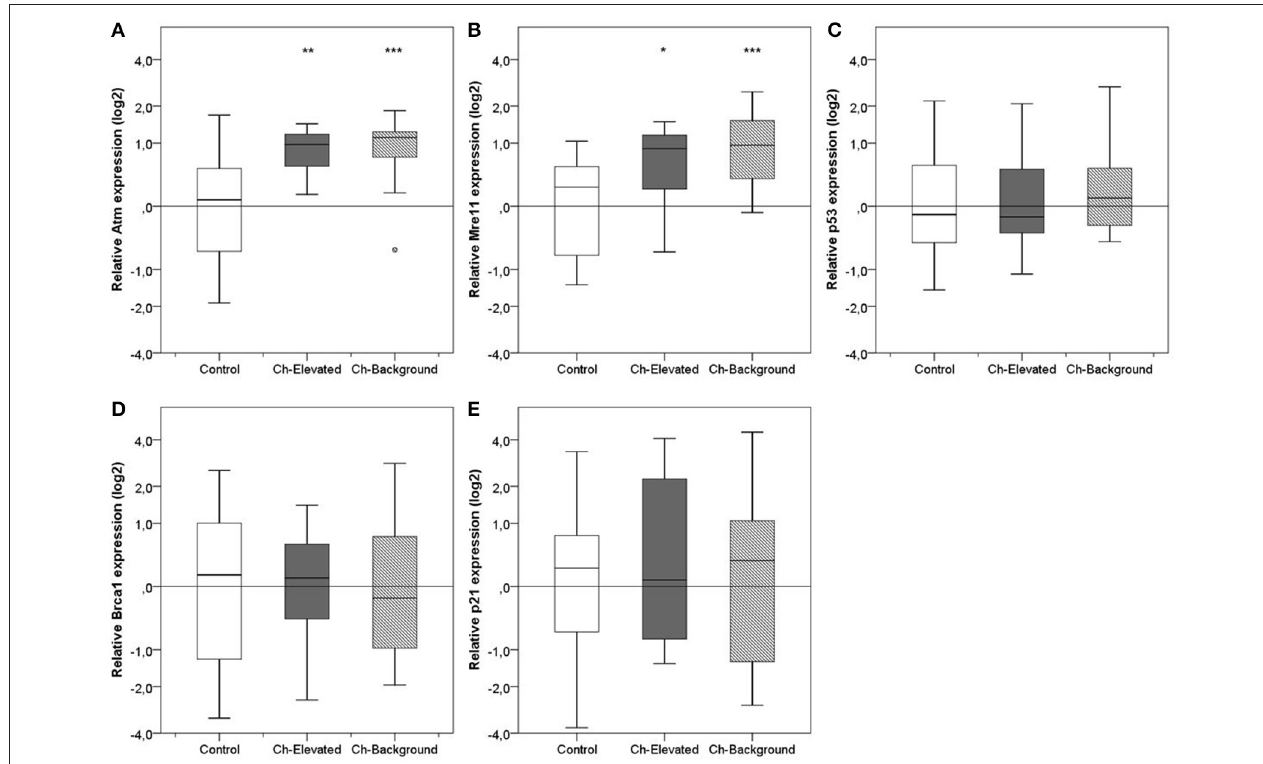
FIGURE 2 | Relative expression of five central DNA damage response (DDR) genes in livers of bank voles collected from the Chernobyl Exclusion Zone (CEZ) (Ch-Background = < 1.0 µ Gy/h, Ch-Elevated = up to 12.3 µ Gy/h) and control locations outside the CEZ. Gene expression was normalized against two internal reference genes ( Actb and Rer1 ) with the average expression in the control group set as the reference level. (A) Atm, (B) Mre11 , (C) p53, (D) Brca1, and (E) p21 . * p < 0.05; ** p < 0.005; *** p <